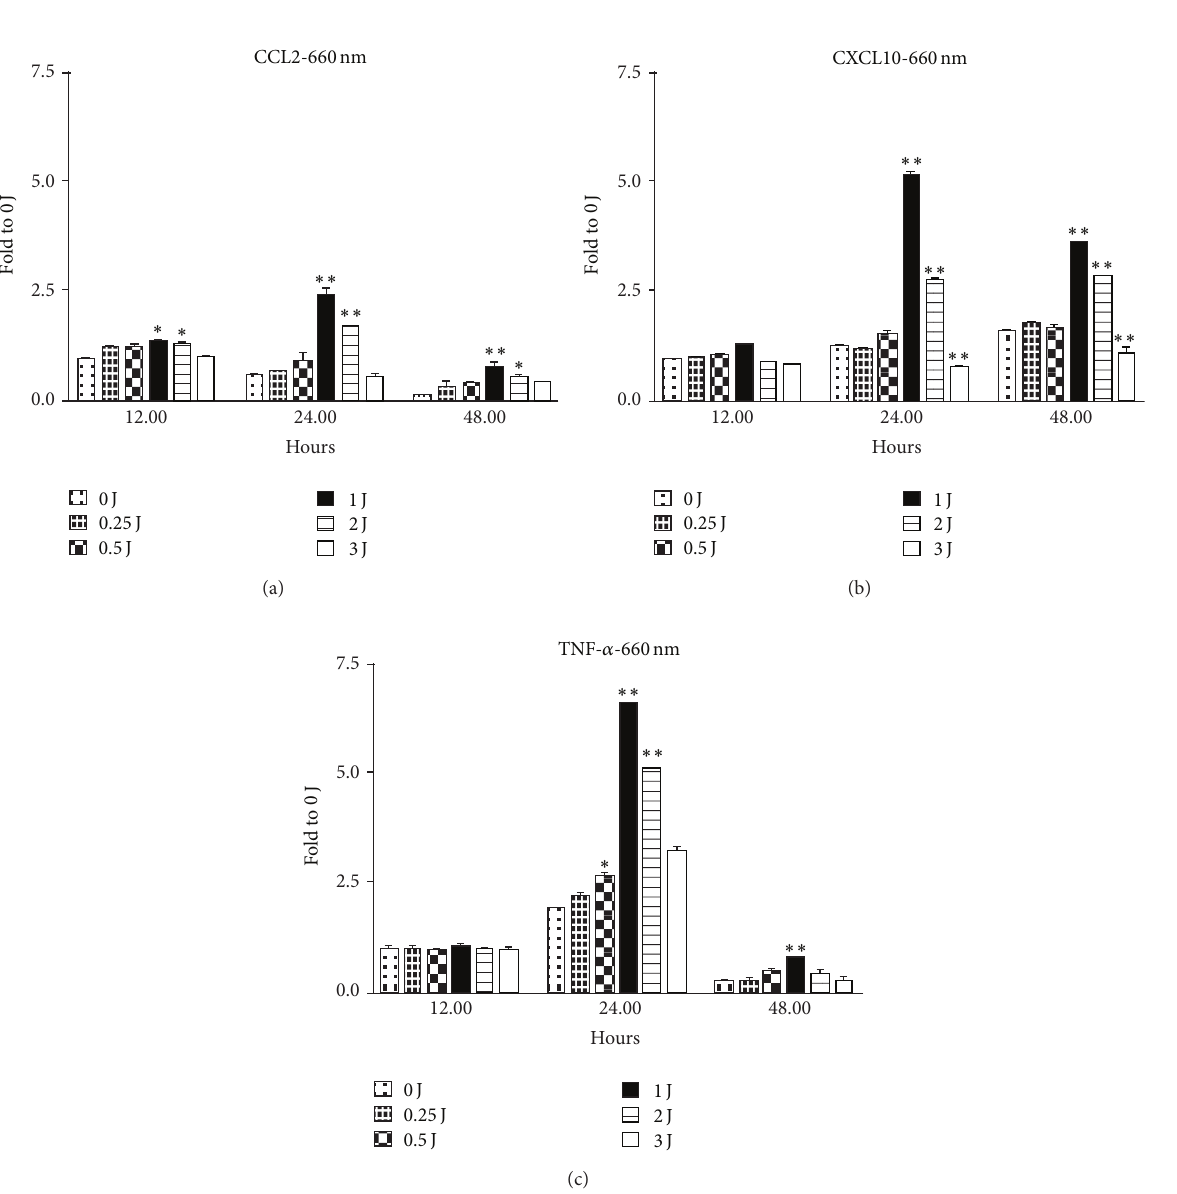
Figure 2: The effects of LLLT on the expression of M1-related cytokines and chemokines CCL2 (a), CXCL10 (b) and TNF- 𝛼 (c) mRNA at 12h, 24 h, and 48 h time points using real-time PCR analysis. ∗ 𝑃 < 0.05 ; ∗∗ 𝑃 < 0.01 ; and ∗∗∗ 𝑃 < 0.001 between control and LLLT